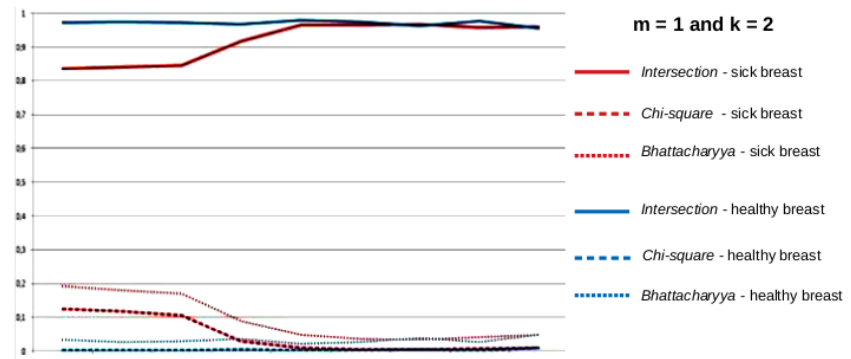
Figure 12. Time series based on the comparison of histograms, for healthy (blue) and sick (red) breasts, k = 2 and m =